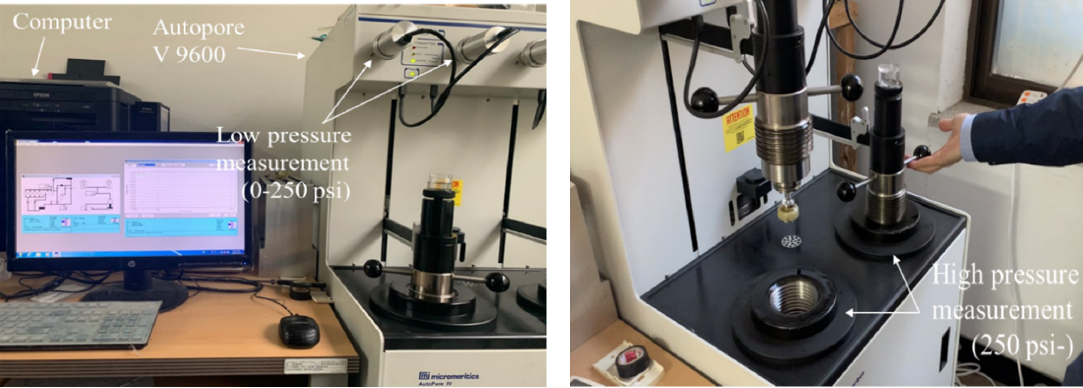
Figure 6. Experiment equipment for mercury porosimeter test.